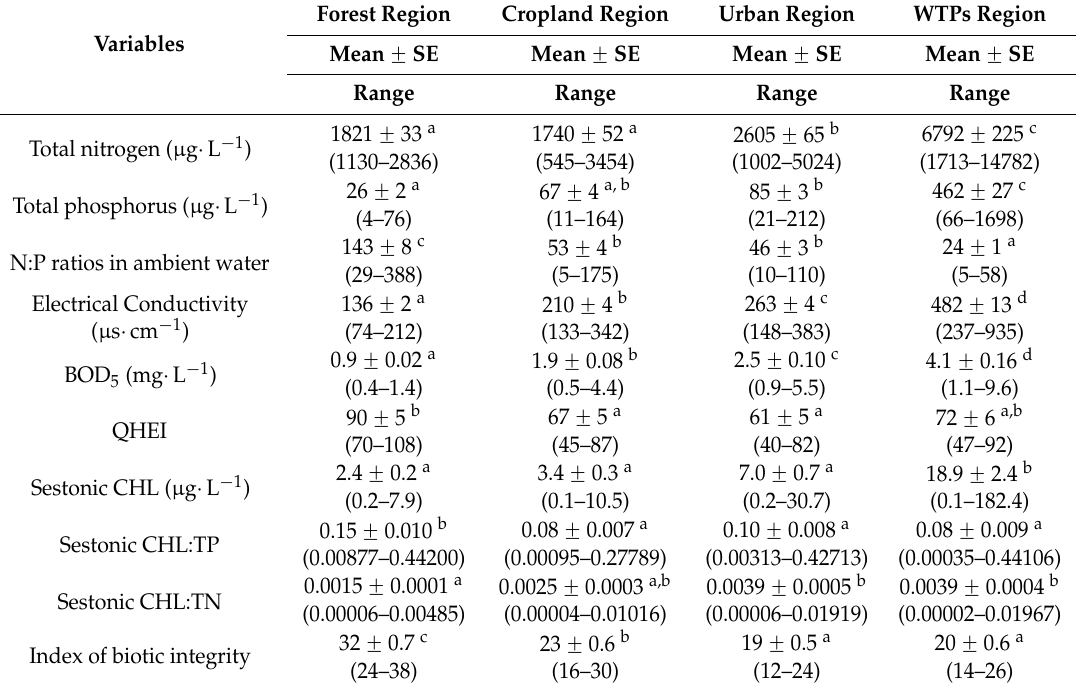
Table 1. Water chemistry, physical habitat condition, and biotic components according to the type of land in the Geum River watershed. Data are provided as means ˘ SE (range: 5%–95%) in each region. The superscript letters indicate significant post-hoc differences according to land use